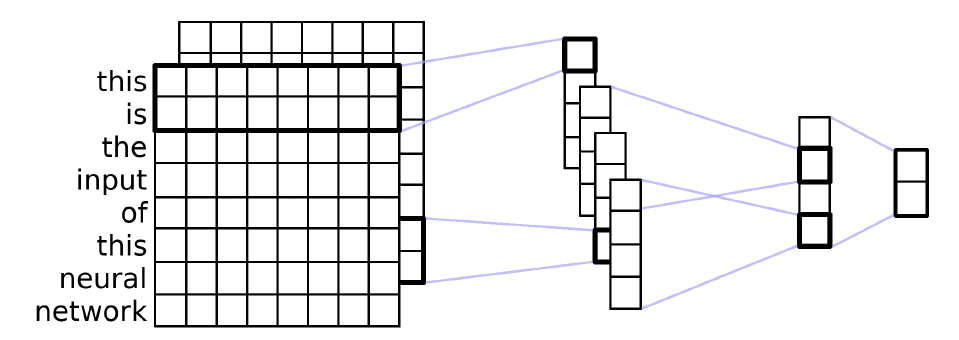
Figure 5. Convolutional architecture. A convolution has multiple filters, and each filter has a kernel (a matrix of weights) that is being trained. The kernel slides over the values from the previous layer, producing values that are sent to the next layer. Each filter learns to recognize a different